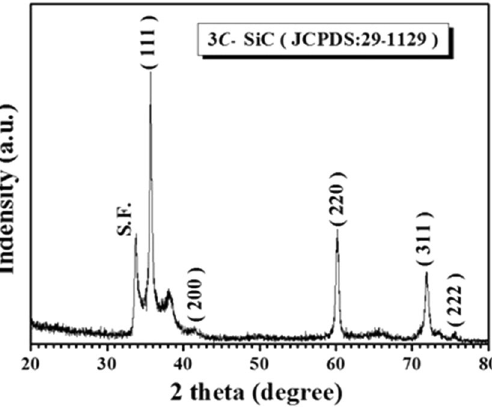
Figure 2. Representative XRD pattern recorded from Sample E after pyrolyzation at 1400 °C for 1 h.